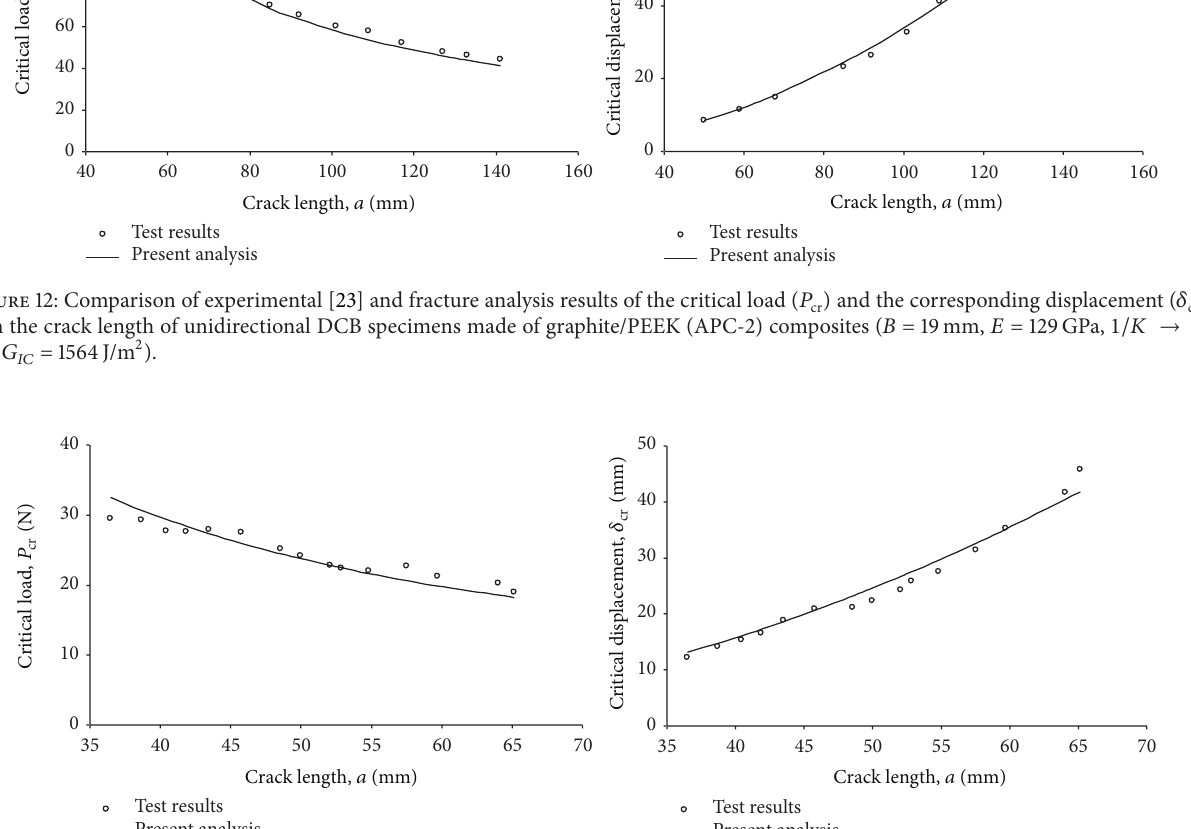
Figure 13: Comparison of experimental [24] and fracture analysis results of the critical load (𝑃 with the crack length of unidirectional DCB specimens made of carbon/PEK-C composites ( 𝐵 = 20 mm, 2 ℎ = 2mm, 𝐸 = 48.2 GPa, 1/𝐾 → 0 , and 𝐺 𝐼𝐶 = 863 J/m 2